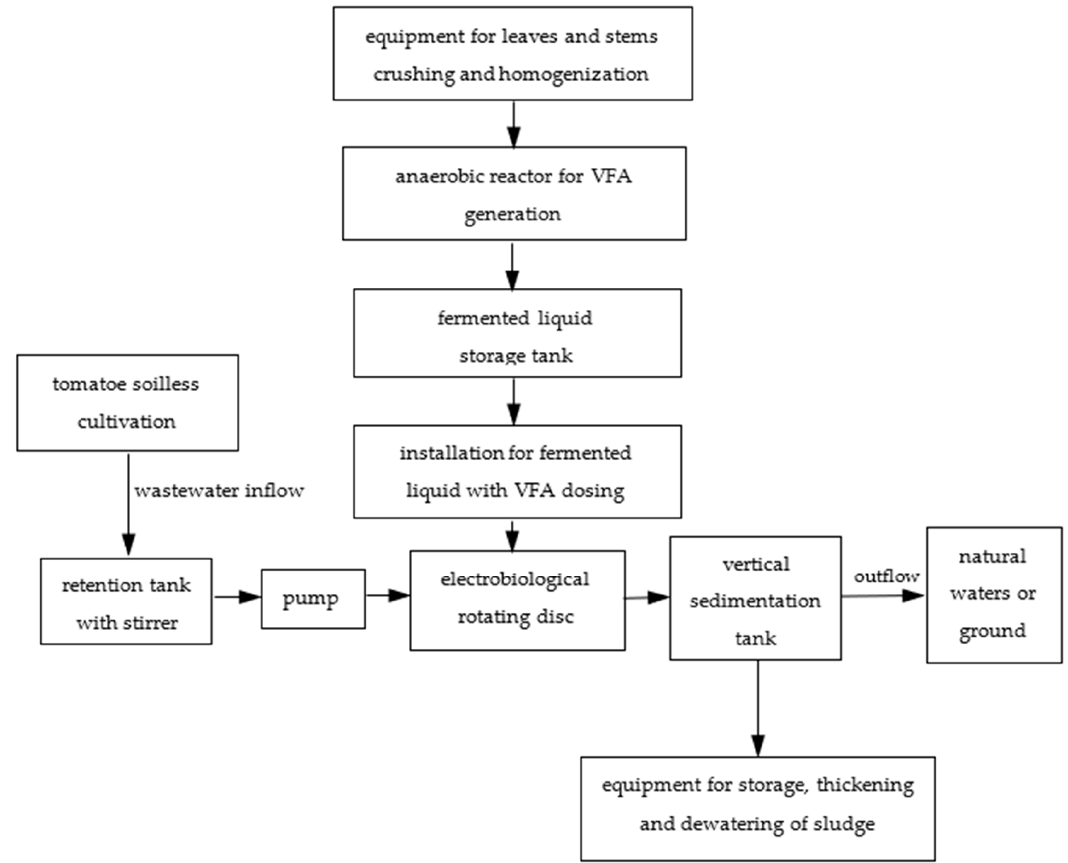
Figure 8. Scheme of a technological system with an electrobiological rotating disc contactor with equipment for VFA generation from leaves and stems crushing, for treating wastewater discharged into natural waters or the ground .